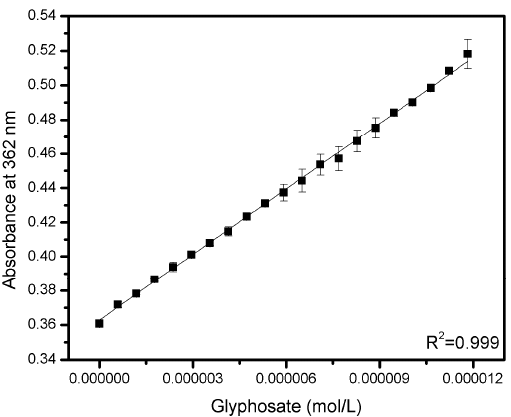
Figure 3. Calibration curve for the detection of glyp (5.9 × 10 − 7 –1.1 × 10 − 5 mol/L) based on the interaction with the compound (Ni(PhDP) 2 ) (1.08 × 10 − 4 mol/L). Reaction conditions: 99% CH 3 OH–1% water.